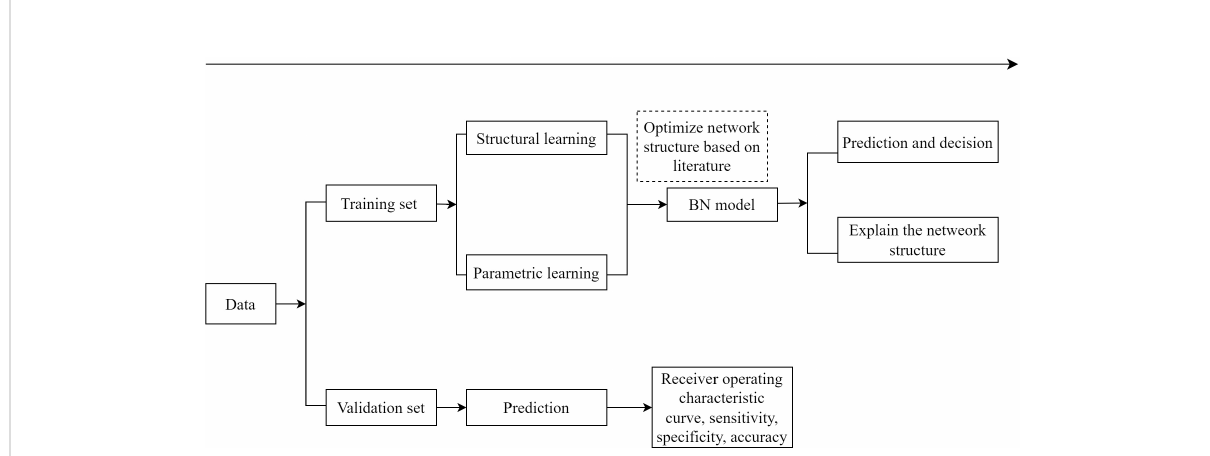
FIGURE 1 The fl ow diagram of Bayesian network